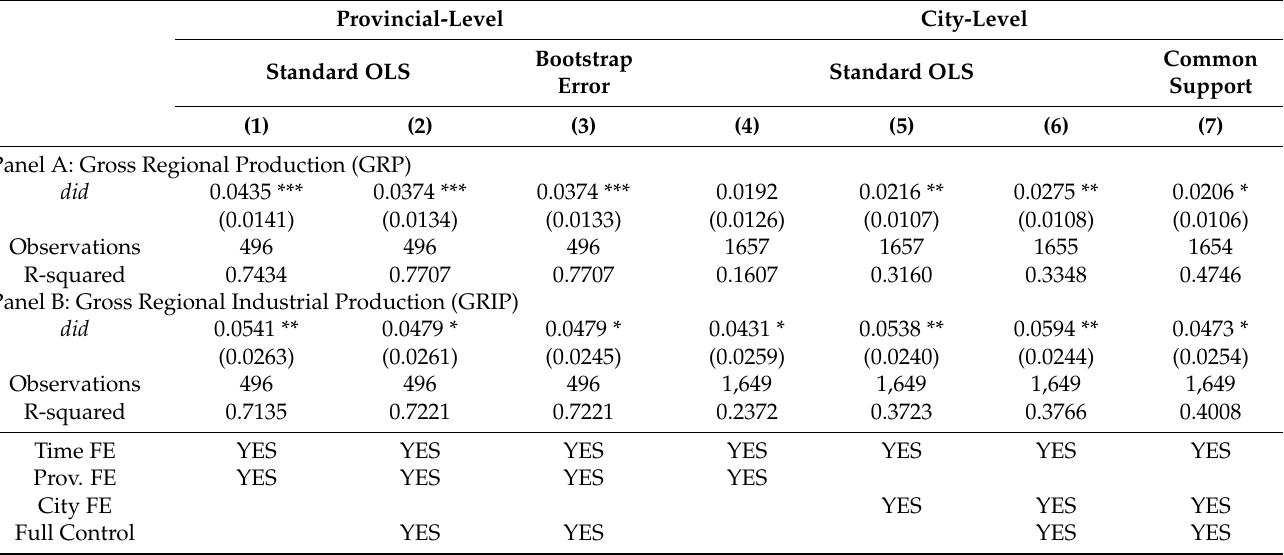
Table 1. Economic impact of the SARS epidemic in China. Provincial-Level City-Level Bootstrap Standard OLS Standard OLS Error